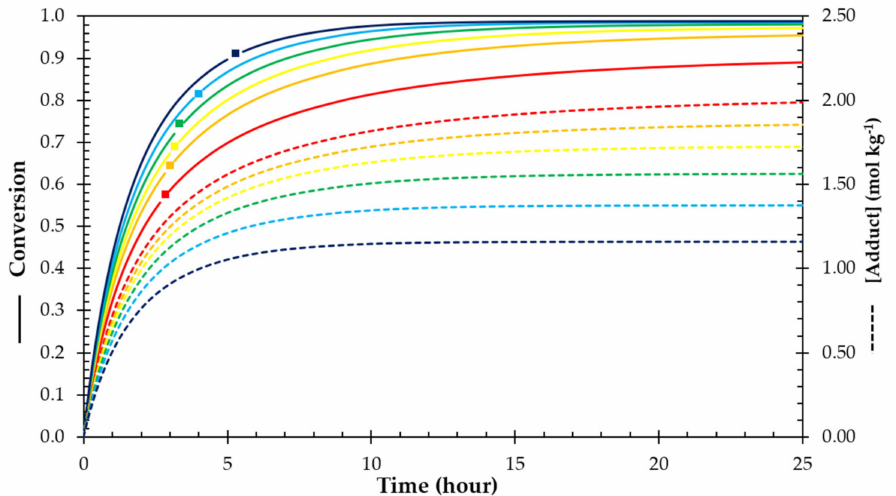
Figure 8. Diels–Alder conversion (solid lines), gelation time (squares), and total adduct concentration (dashed lines) for the DPBM-F400 reversible polymer network with different stoichiometry as a function of time at 25 ◦ C: DPBM-F400 ( r = 1) red, ( r = 0.8) orange, ( r = 0.7) yellow, ( r = 0.6) green, ( r = 0.5) light blue, and ( r = 0.4) dark